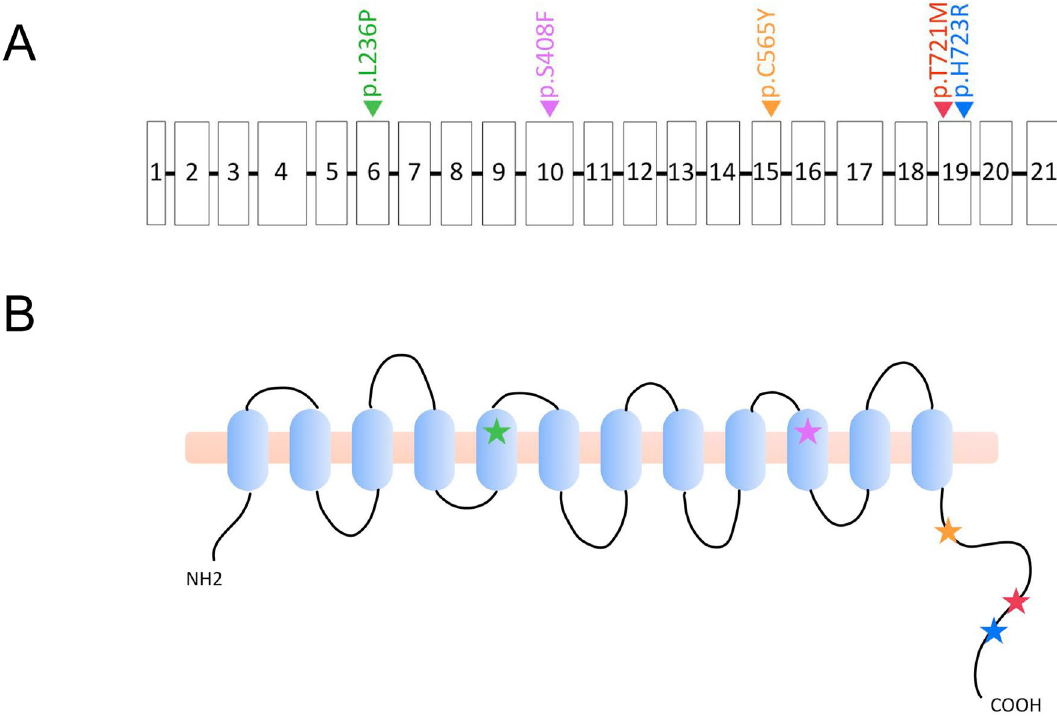
Figure 5. Five documented murine missense Slc26a4 variants. Five mouse models with missense Slc26a4 variants, including p.L236P, p.S408F, p.C565Y, p.T721M, and p.H723R, have been documented in the literature. ( A ) Scheme of the genomic DNA. Squares represent exons and lines represent introns. ( B ) Scheme of the 12-transmembrane domain model of pendrin. The five missense variants are indicated with stars, with p.L236P indicated in green, p.S408F in purple, p.C565Y in orange, p.T721M in red, and p.H723R in blue. L236P and p.S408F are located in the transmembrane domains, whereas p.C565Y, p.T721M, and p.H723R are located at the C-terminus of